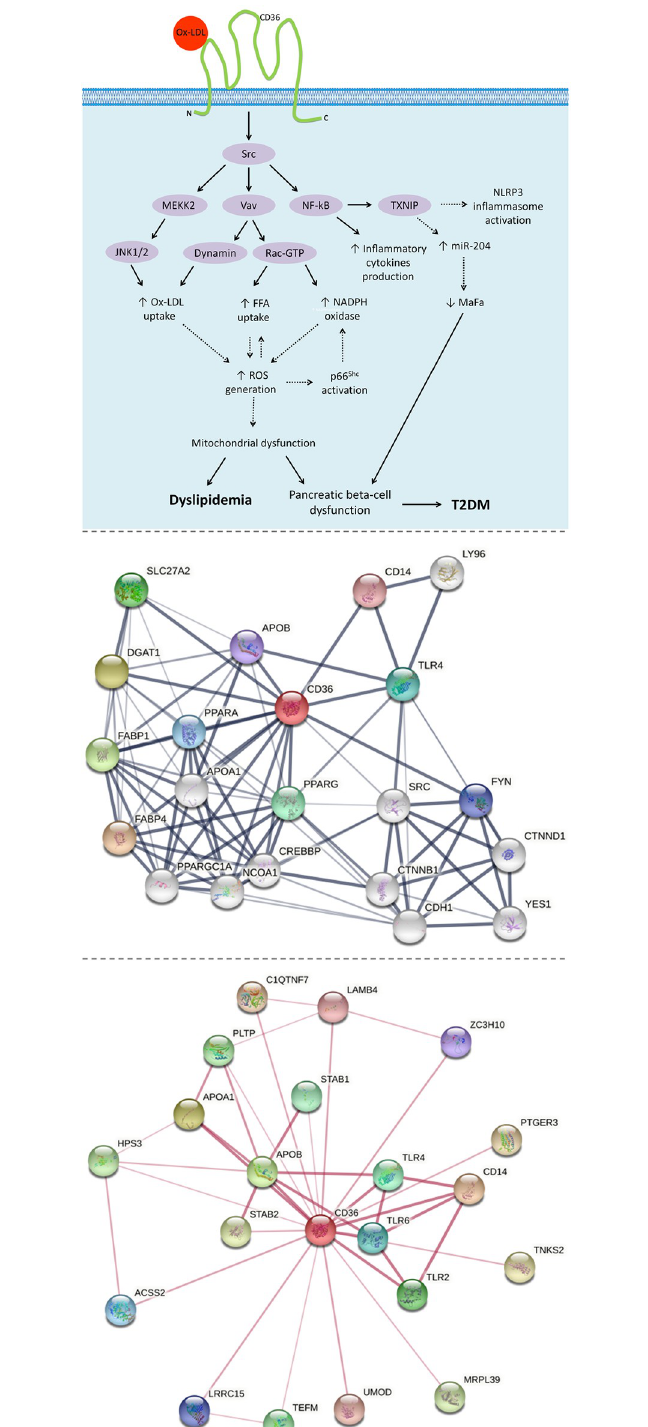
Fig 7. The signal and interaction networks of CD36. The upper illustration represents the potential signaling pathways of Ox-LDL/CD36 that promote T2DM and dyslipidemia. The oxidized low-density lipoprotein (Ox-LDL) initiates the activation of CD36 which bounds to membrane-associated Src family non-receptor tyrosine kinases. This interaction enables three main cytoplasmic signaling domains; nuclear factor kappa B (NF- κ B), mitogen-activated protein kinase kinase kinase 2 (MEKK2), and Vav-mediated signaling pathways. Activation of NF- κ B contributes to